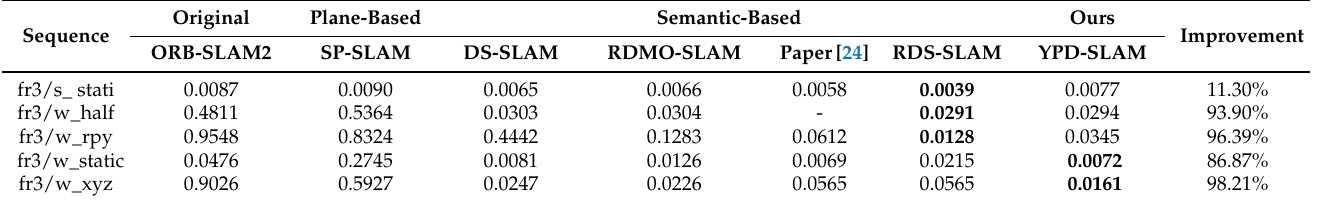
Table 1. Experimental RMSE results of absolute trajectory error (ATE). Our method is YPD-SLAM, and Improvement stands for comparison with the original algorithm ORB-SLAM2.